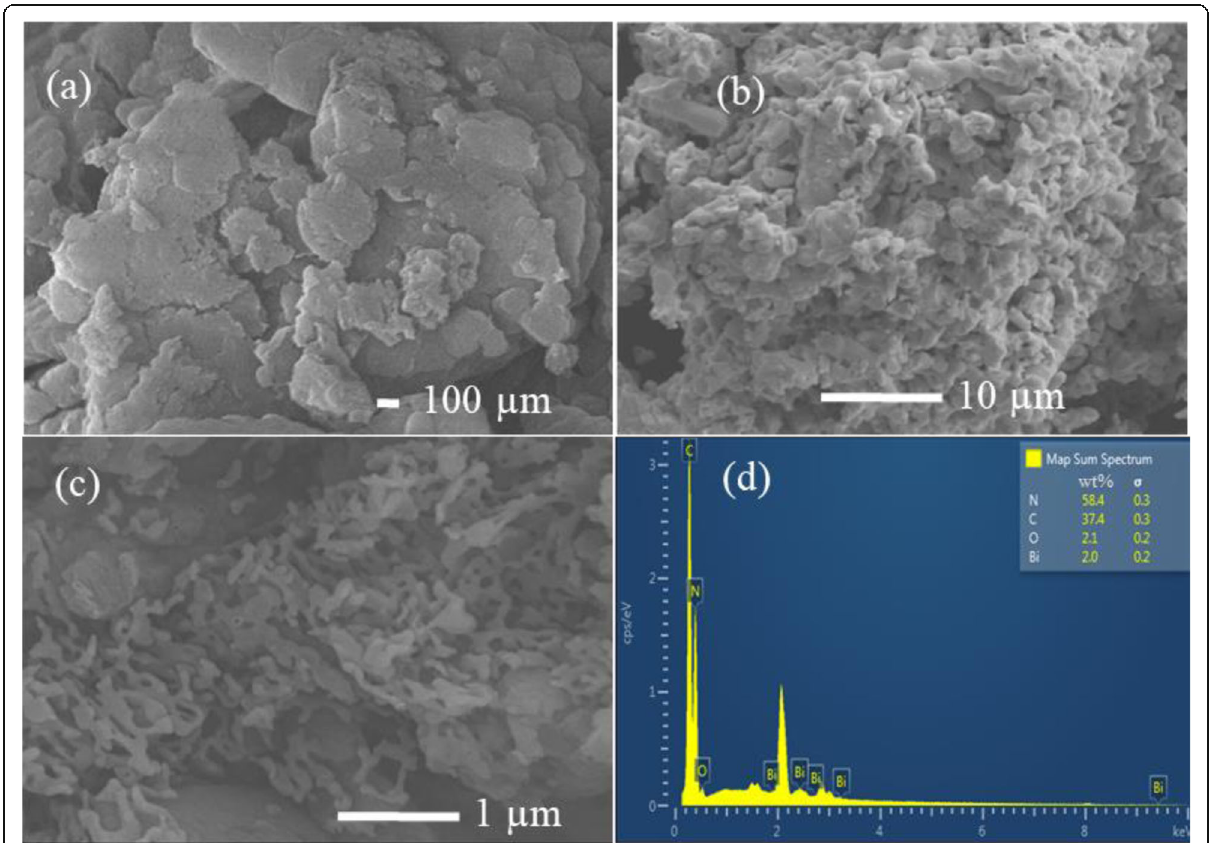
Fig. 1 SEM images of ( a ) g-C 3 N 4 , ( b ) α -Bi 2 O 3 and ( c ) 1 wt% α -Bi 2 O 3 @g-C 3 N 4 and ( d ) EDS spectra of 1 wt% α -Bi 2 O 3 @g-C 3 N